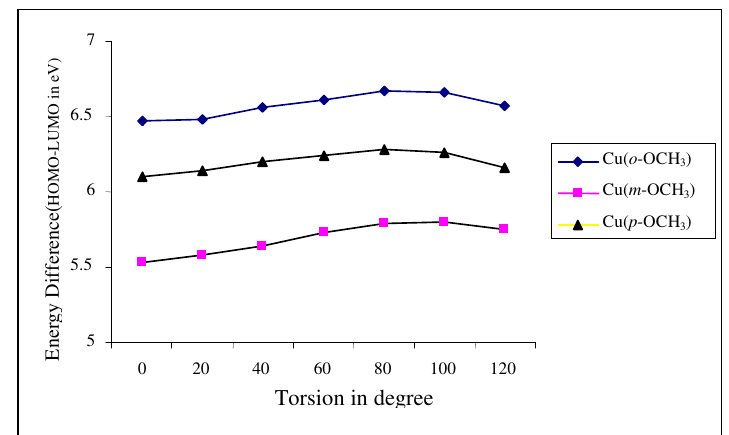
Figure 10 . Evolution of HOMO-LUMO energy difference as a function of torsion angles for un-substituted, ortho, meta and para- methoxyl Cu[C